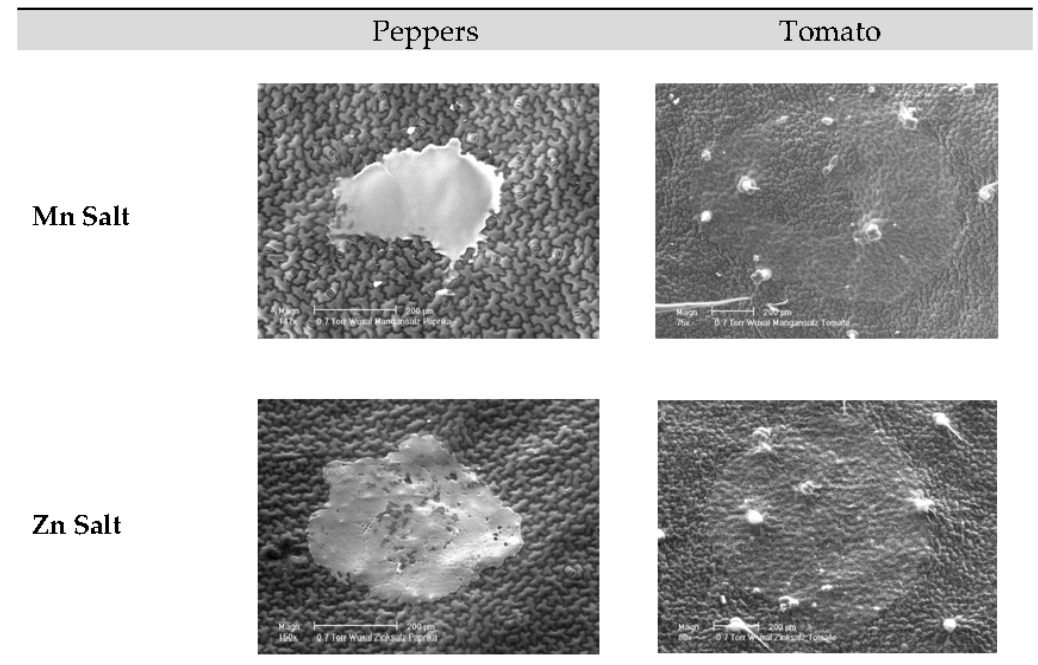
Figure 7. Representative micrographs taken with a scanning electron microscope (please note the scale of each figure) used in Experiment 2.